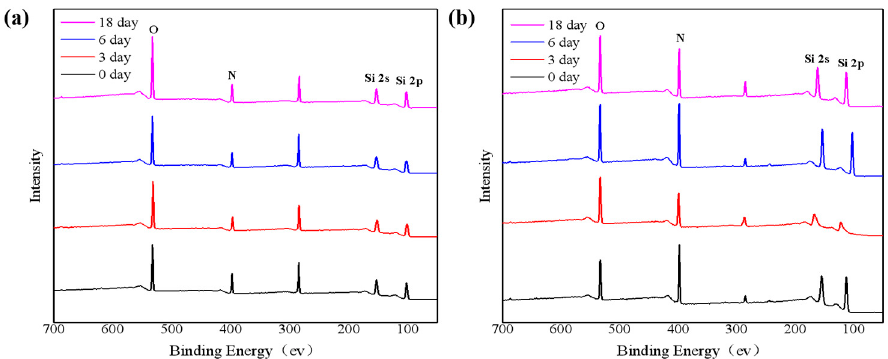
Figure 1. XPS analysis of ( a ) surface and ( b ) 200 nm inside of for SiN x films oxidized at different times in the air.